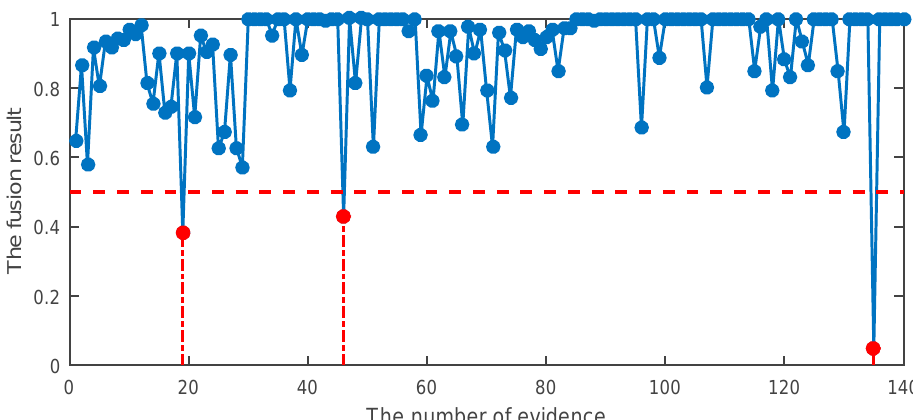
Figure 13. The fusion result using the proposed hybrid classifier ensemble (HCE) combined with the improved DST. Sensors 2019 , 19 , x